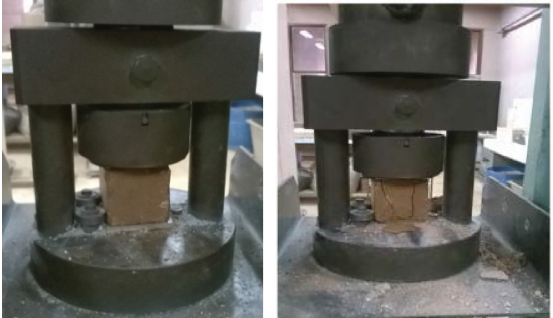
Figure 3: Simple compression tests on 4 × 4 × 4 cm 3 CSEB samples.